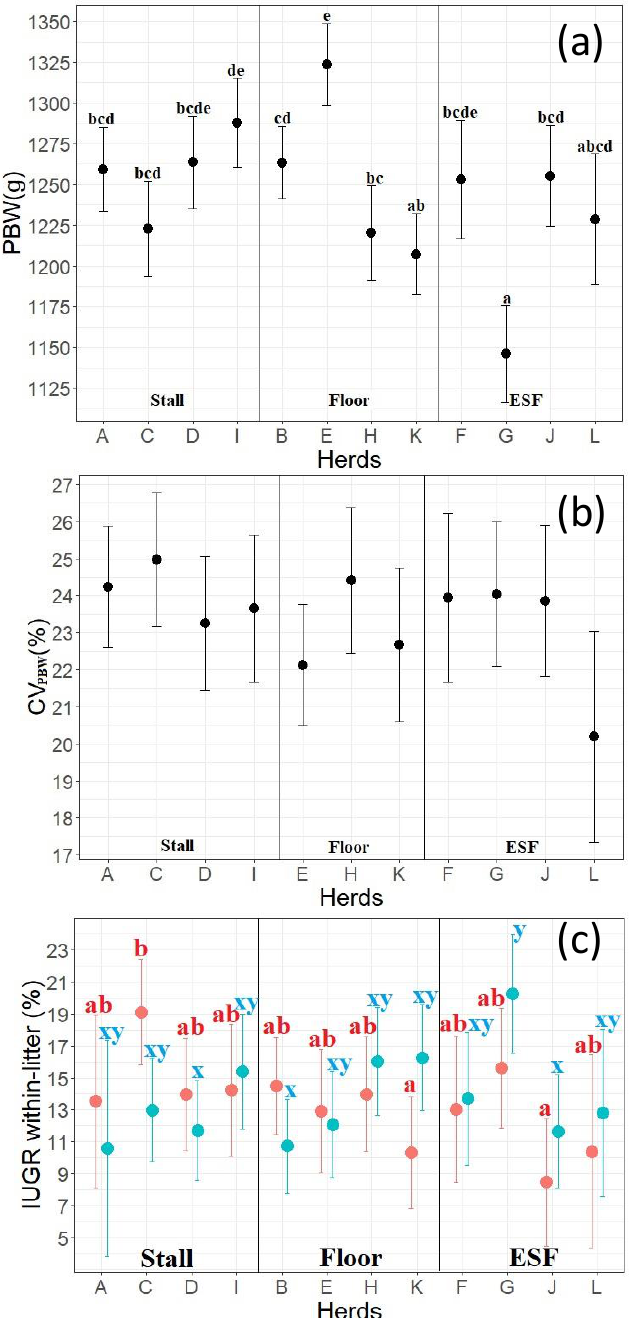
Figure 7. LSmeans of ( a ) piglet birth weight (PBW), ( b ) within-litter variation in PBW (CV PBW ) and ( c ) within-litter proportion of either severe IUGR (sIUGR (red)) or mild IUGR (mIUGR (blue)) for 2nd to 9th parity sows of the different herds, described by the capital letters A–L on the x -axis, with visual separation by feed systems. Stall describes free-access feeding stalls, Floor describes floor feeding and ESF describes electronic sow feeding. a–e Values with different superscripts differ between herds for PBW and sIUGR ( p < 0.05); x,y Values with different superscripts differ between herds for mIUGR ( p <